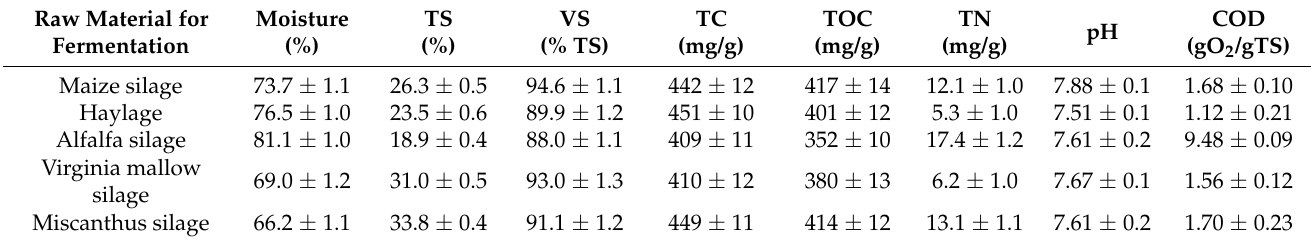
Table 1. Characteristics of the energy crop silage used in the experiment.